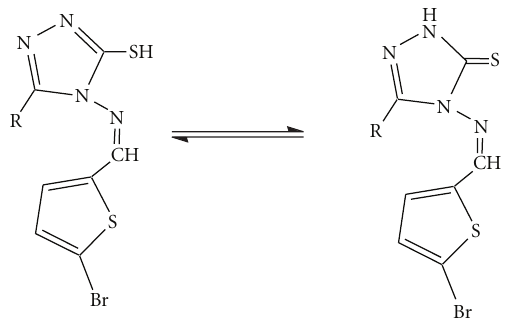
Figure 1: Structure of Schi ff bases, where R = –CH 3 , HL 1 = 4-(5-